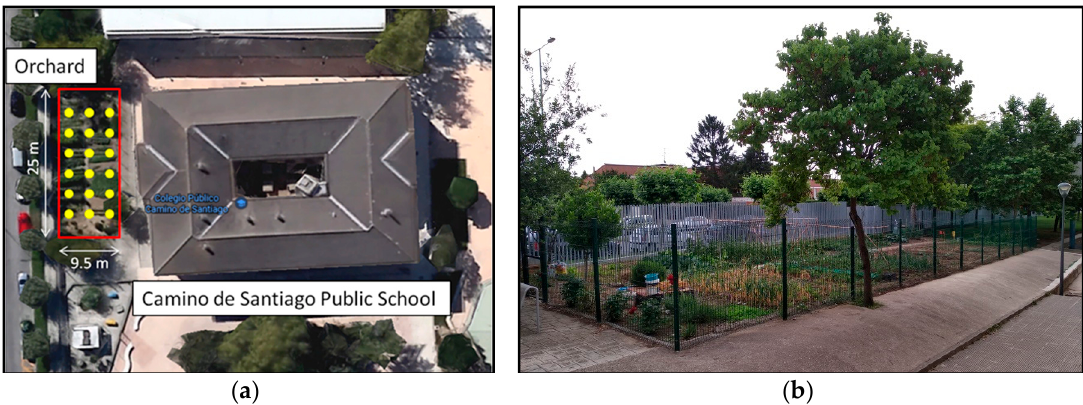
Figure 1. ( a ) ‘Camino de Santiago’ public school’s upper view; ( b ) A picture of the school’s